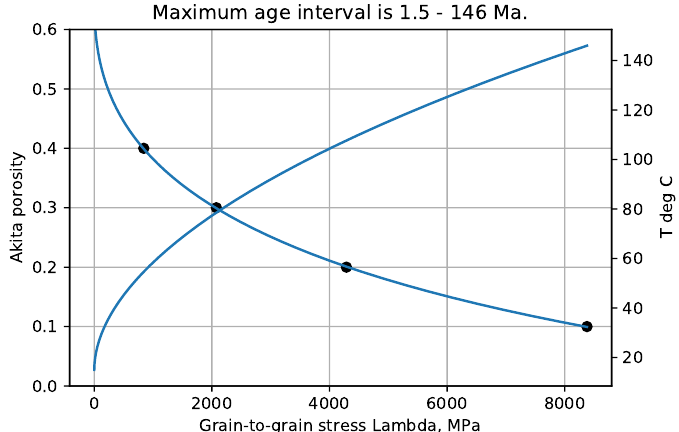
Maximum age interval is 1.5 - 146 Ma.